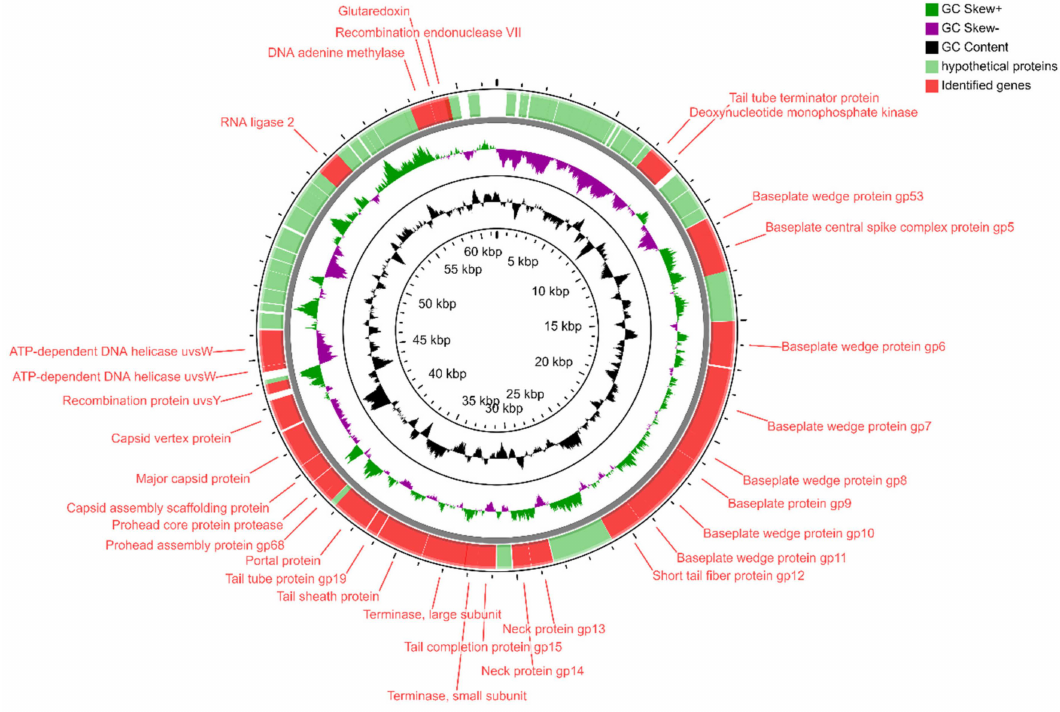
Figure 12. Map of the genome organization of Citrobacter phage KKP 3664 created by using the CGView program